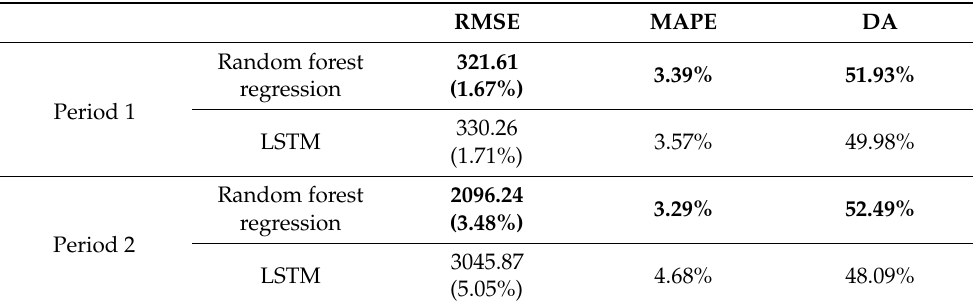
Figure 14. Relationship between accuracy and the number of lags (LSTM). Table 9. Model evaluation using the accuracy and error.